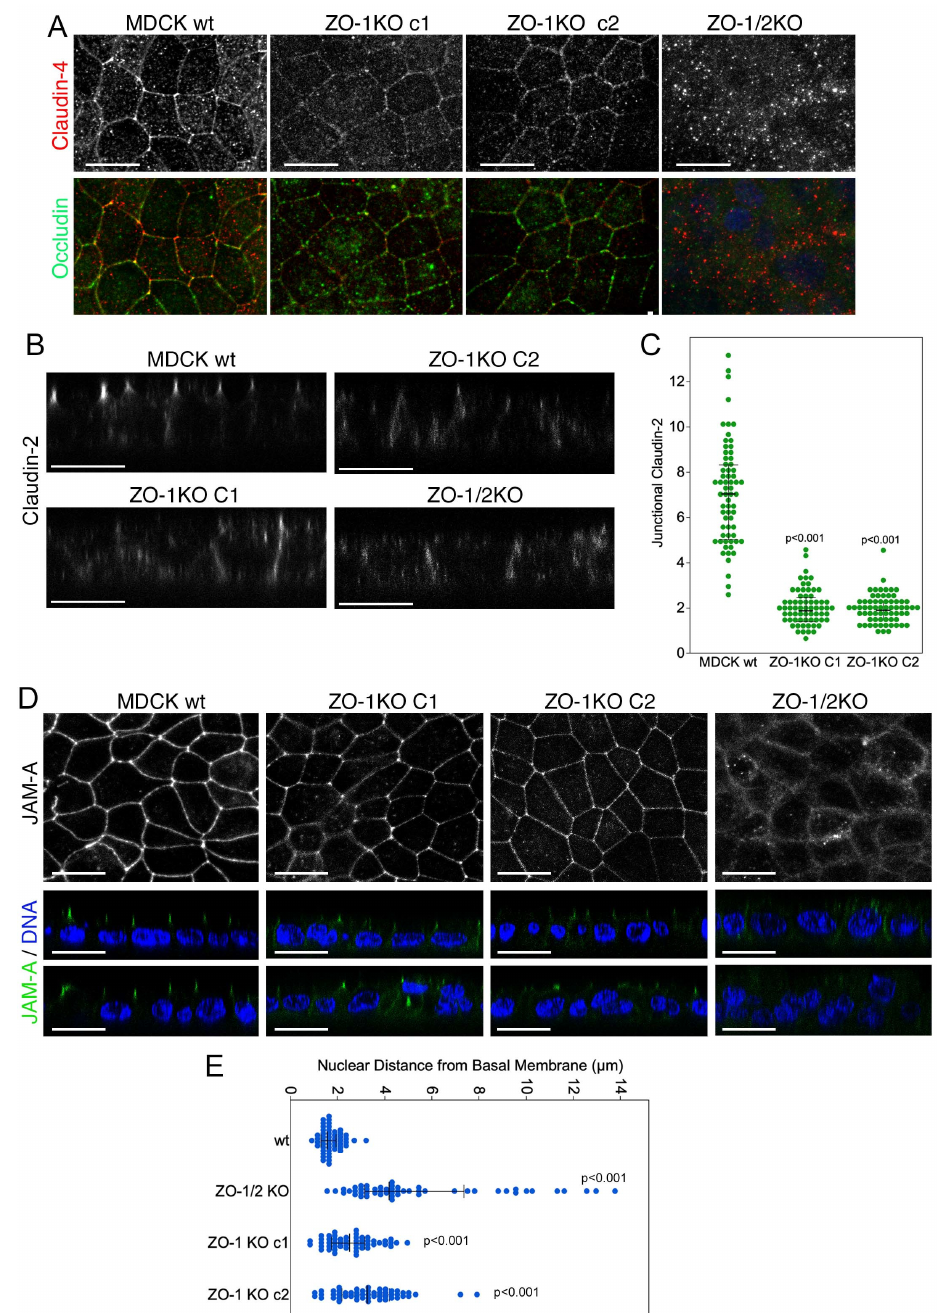
Figure 9. ZO-1-deficiency inhibits junctional protein recruitment in filter-grown cells. Confluent wild-type and knockout MDCK seeded on permeable supports were analysed by immunofluorescence confocal microscopy ( A , B , D ). All confocal XY sections are maximum intensity projections of all sections containing junctional staining. Additional junctional markers and xy-sections along with a quantification of z-sections of samples stained for JAM-A and occludin are shown in supplemental Figure S8. Panel ( C ) shows quantification of junctional claudin-2 staining on z-scans. Panel ( E ) shows a quantification of the nuclear position derived from z scans of JAM-A samples analysed in ( D ). Data points in panels ( C , D ) are derived from individual cells. Magnification bars, 20 μ m.